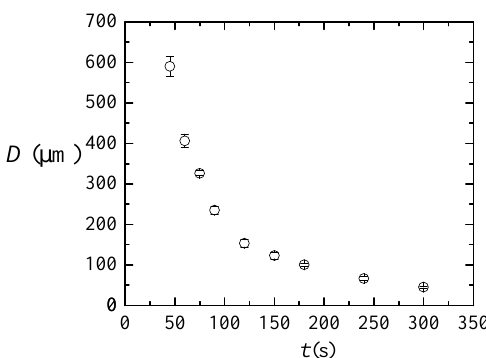
Figure 2. Mean neck diameter for sets of nozzles manufactured at the same heating position ( r = 3.5 mm, z = 15 mm) from capillaries type 1. The standard deviation is used for the error bars.